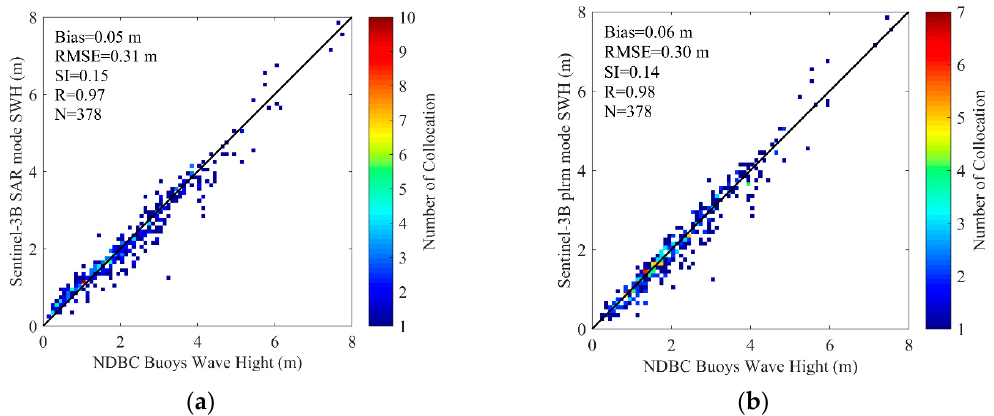
Figure 10. Scatterplots for the SWH comparisons between Sentinel-3B ( a ) SAR and ( b ) PLRM modes and NDBC buoys.